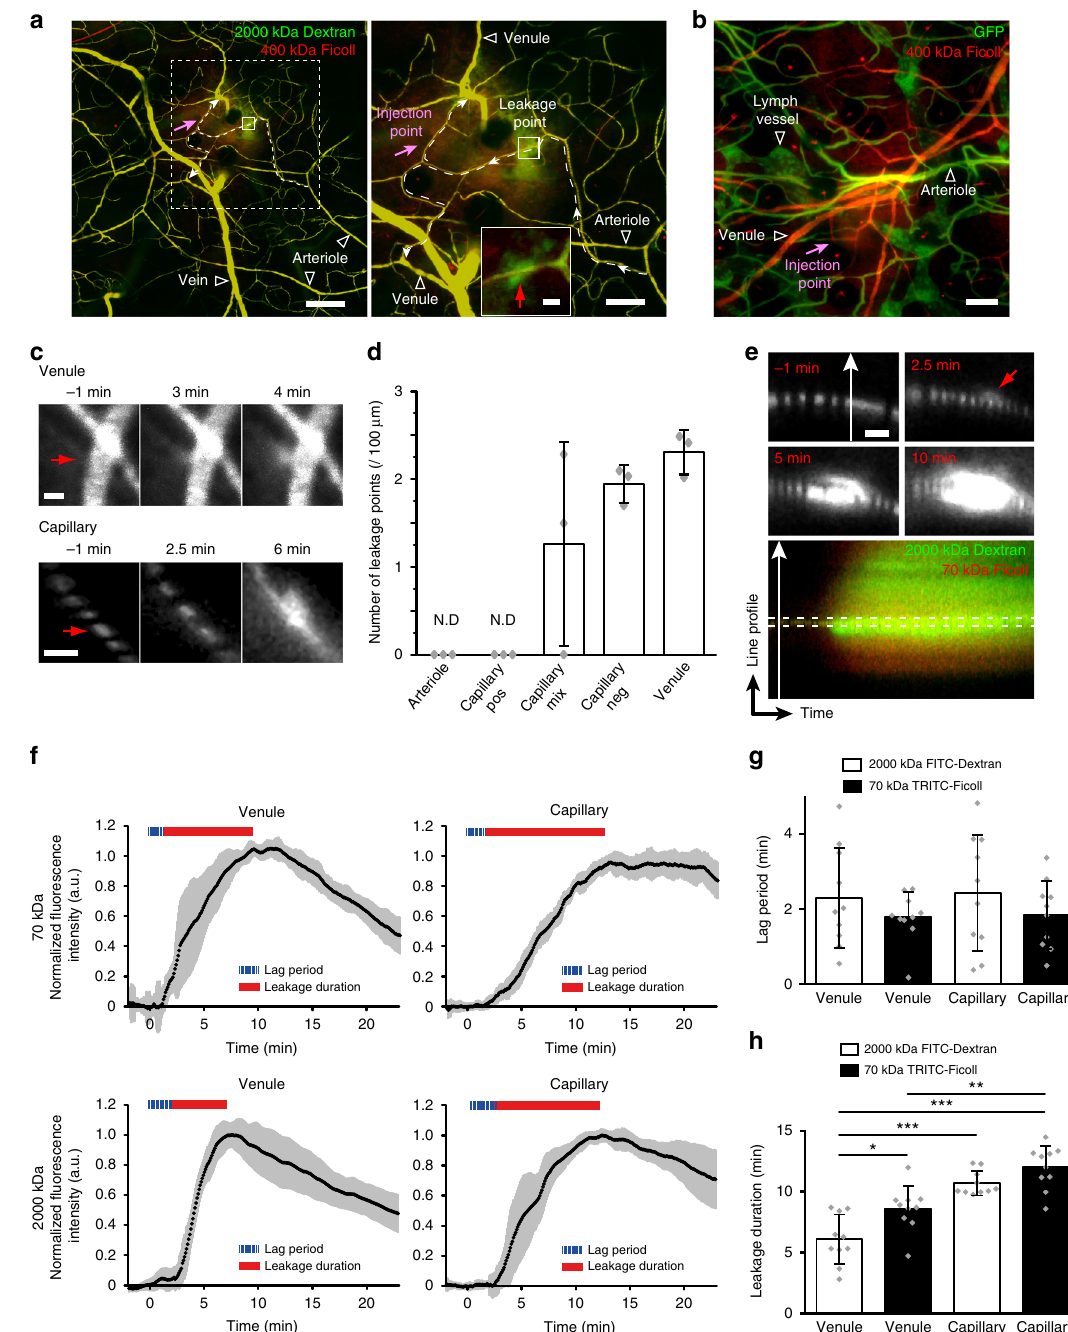
Fig. 4 Dynamics of VEGFA-induced vascular leakage. a Point of leakage of circulating 2000kDa FITC-Dextran and 400 kDa TRITC-Ficoll in a large observation area (left) and zoom-in (right). Flow direction (arrows) and leakage point in a capillary (dashed line), with leakage point boxed (solid line). Right panel, magni fi cation of dashed box area. Capillary leakage point indicated by red arrow. Bar, 200 (left), 100 (right) and 10 μ m (inset). b Leakage of 400 kDa Ficoll in response to VEGFA164 in the ear dermis of Cldn5 (BAC)-GFP mice. Bar, 100 μ m. c Leakage points (red arrow) in Cldn5 (BAC)-GFP mouse dermis, in venule (upper) and capillary (lower), showing progressive leakage over time of 400 kDa TRITC-Ficoll in response to VEGFA164. Bar, 10 μ m. d Quanti fi cation of leakage points/vessel length in the Cldn5 (BAC)-GFP ear dermis. Capillaries with GFP expression (positive; pos), mixed (mix) or no GFP (negative; neg) expression were analyzed. Note that Cldn5-expressing capillaries do not leak. N.D.; not detected. n = 3 mice with 6 vessels of each type analyzed/mouse. e Representative leakage point captured by sXYT imaging at − 1, 2.5, and 10 min after injection of VEGFA164 (upper and middle panels). Kymograph image (lower panel) for analysis of leakage dynamics of 2000 kDa FITC-Dextran and 70 kDa TRITC-Ficoll was made from the point indicated by the white arrow line in upper panels. Red arrow indicates the leakage point. Bar, 10 μ m. f Leakage kinetics from venules (left) and capillaries (right) of 70 kDa TRITC-Ficoll (upper) and 2000 kDa FITC-Dextran (lower) with lag periods and leakage durations indicated. Gray area around solid black line indicates variability (S.D.). n = 7 mice with 10 capillaries and 10 venules analyzed. g Quanti fi cation of lag periods (min) for the different conditions. n = 7 mice and 10 vessels/condition as in f . No signi fi cant difference by Tukey – Kramer test. h Quanti fi cation of leakage duration (min) for the different conditions. n = 7 mice and 10 vessels/condition as in f . Tukey – Kramer test; * p < 0.05, ** p < 0.01, *** p <